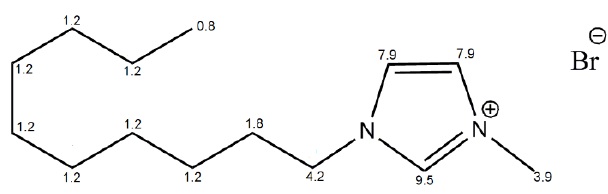
Figure 15. Structural formula of DmiBr with marked protons.